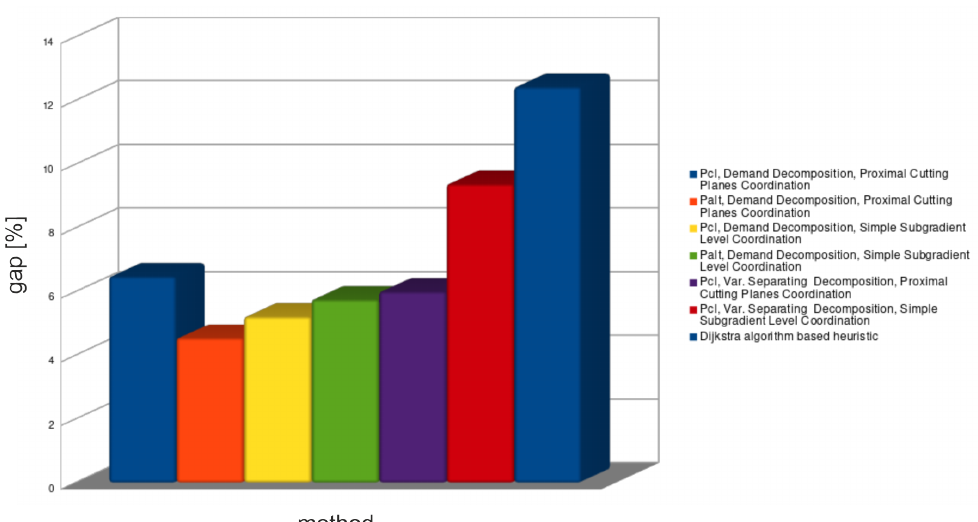
Figure 4. Average upper bound relative gap for all decomposition methods—medium problems.